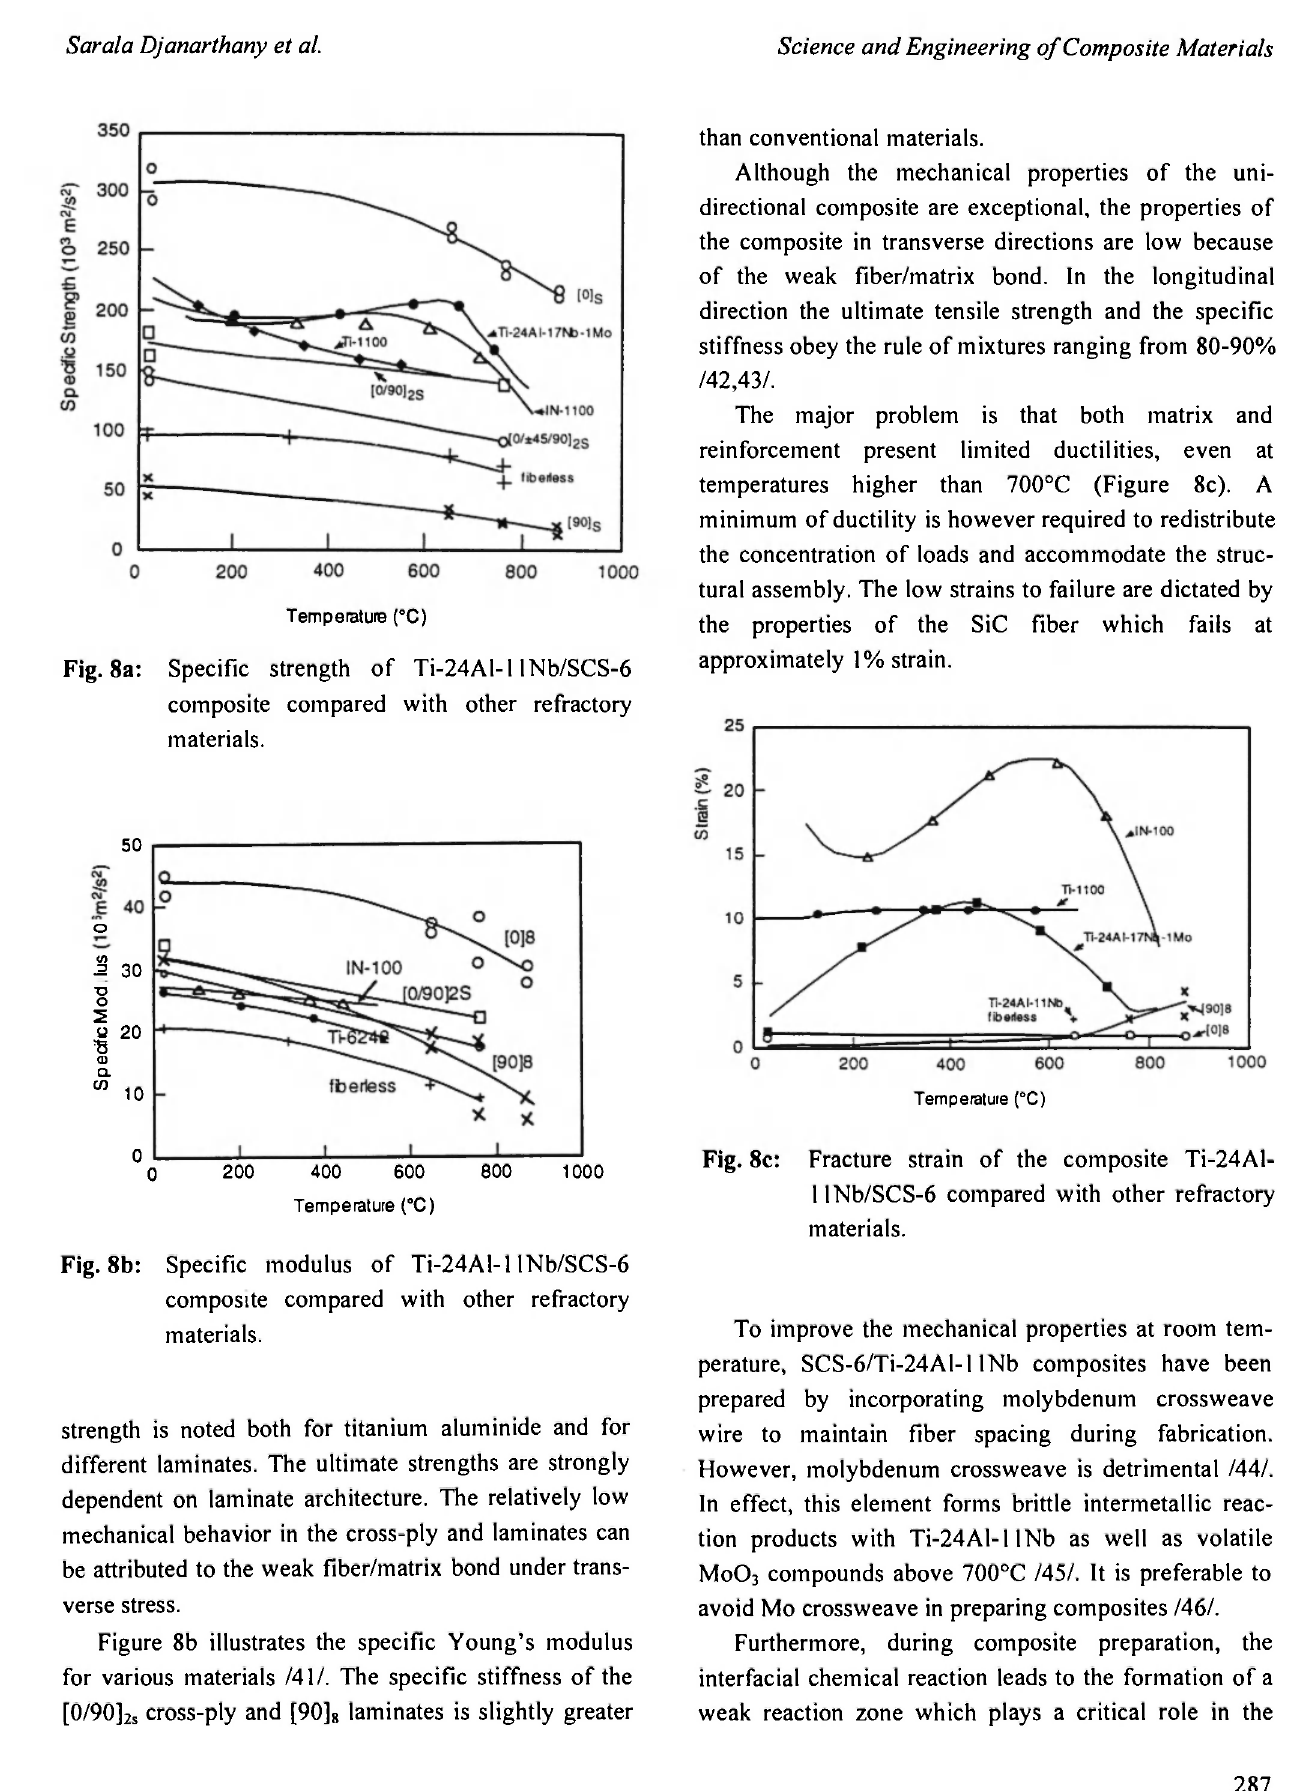
Fig. 8b: Specific modulus of ΊΠ-24Α1-1 lNb/SCS-6 composite compared with other refractory materials.